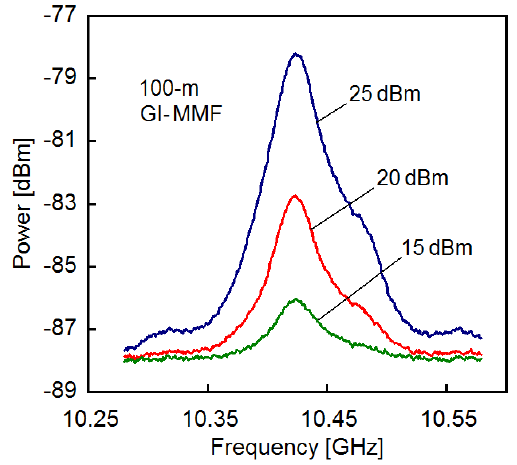
Figure 4. BGS of the 100 m GI-MMF at the pump power of 15, 20, and 25